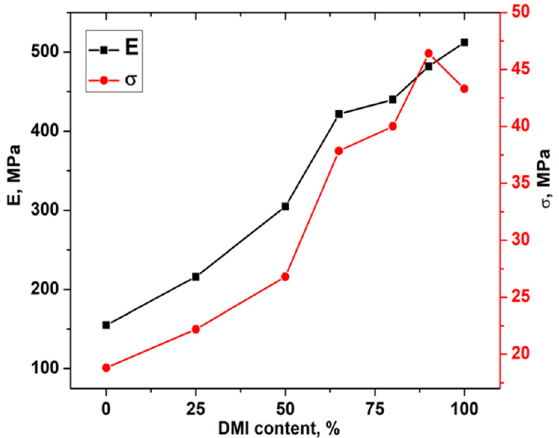
Figure 5. Tensile strength and Young’s modulus of the cured samples.